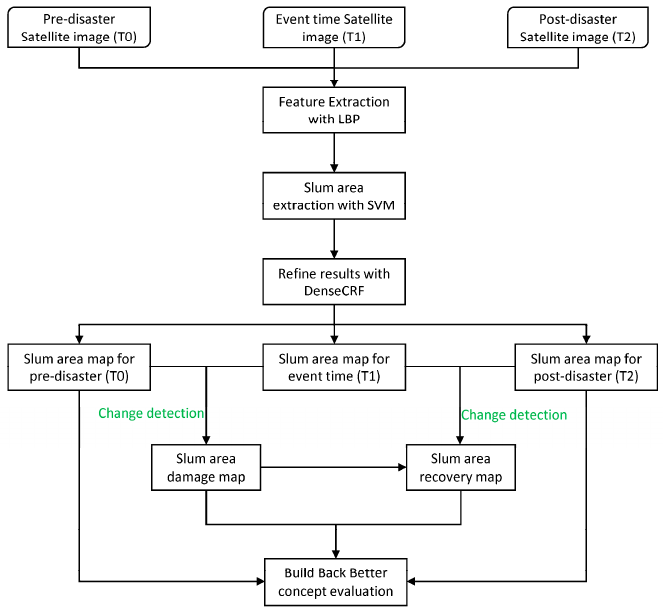
Figure 2. The proposed framework for slum area extraction and build back better concept evalua- tion from multi-temporal satellite images in case of disaster